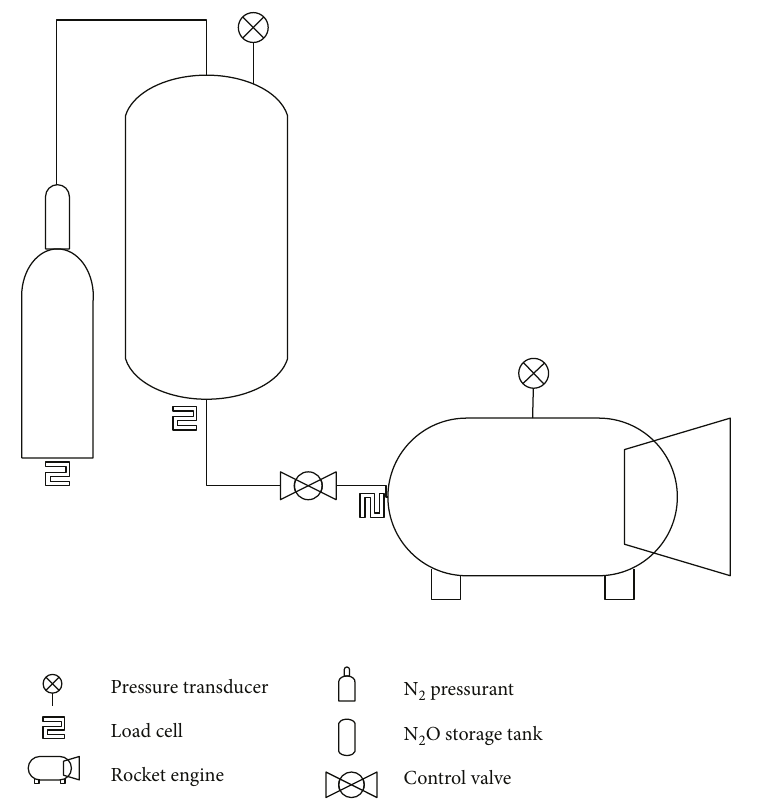
Figure 5: Schematic diagram of the test setup of 250 kgf class DVF